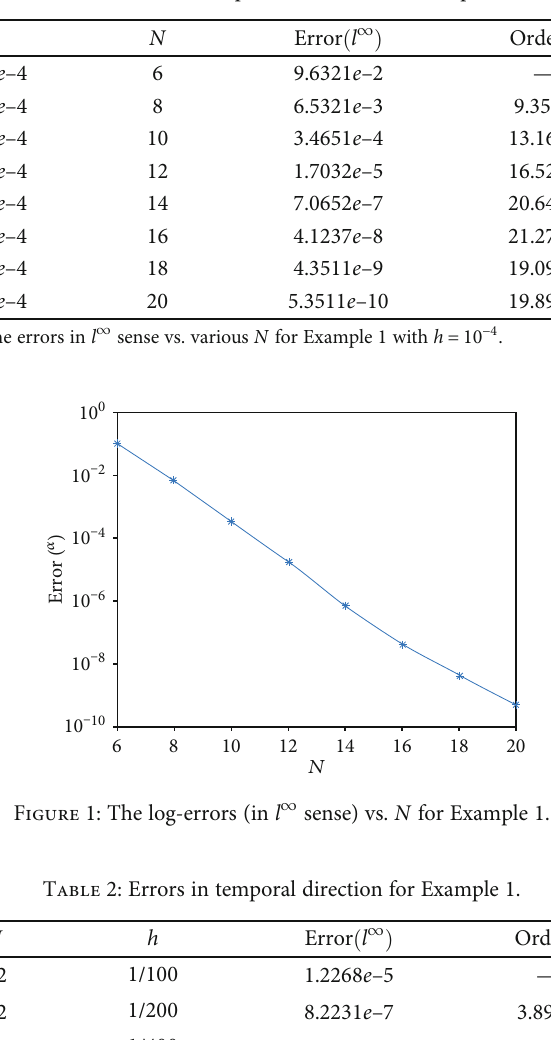
Table 1: Errors in spatial direction for Example 1.